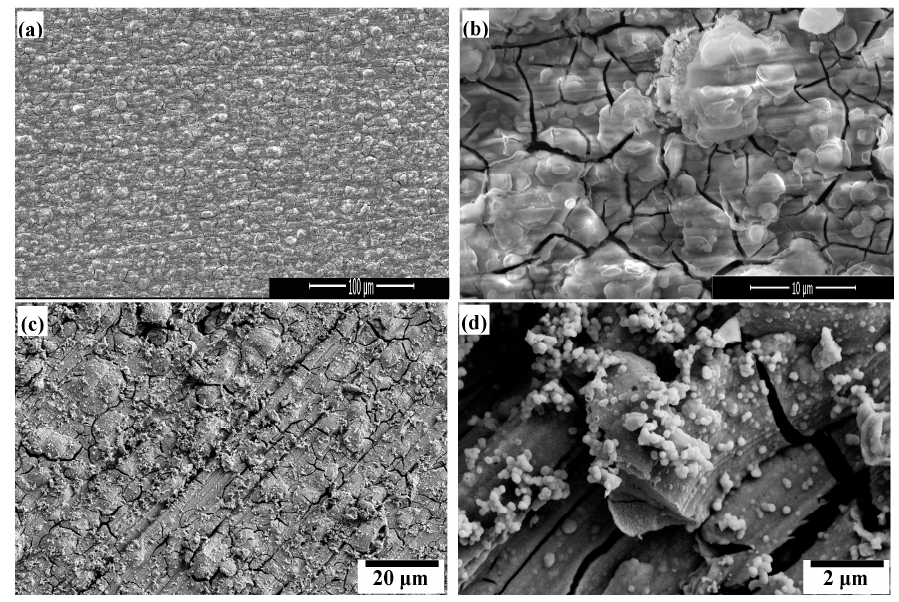
Figure 1. SEM morphology of different films: ( a , b ) the film formed by the optimum process and ( c , d ) the film for comparison.